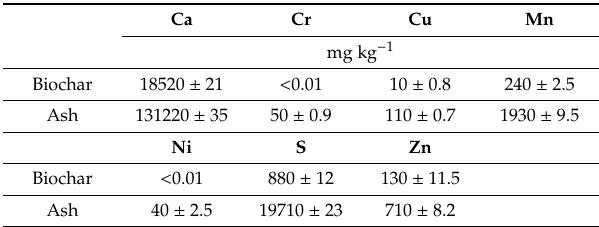
Table 2. Mean concentrations of the selected macro- and micro-elements ( ± SD) in the natural fertilizers ( n =